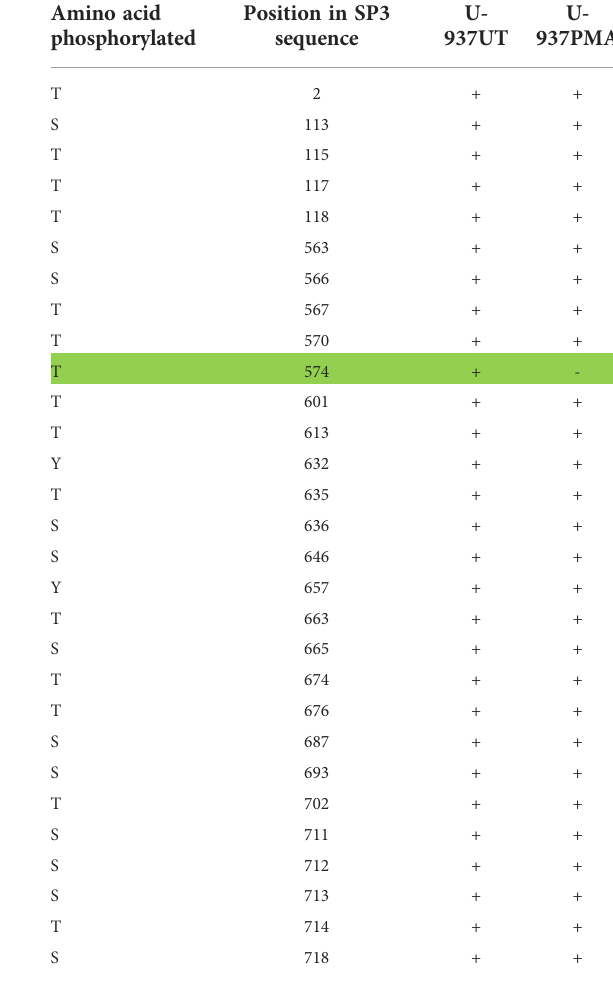
(UT- untreated and PMA- PMA 0.5 m M treated). (+indicatesphosphorylation;-indicatednophosphorylation;phosphoRsiteprobabilities of 75% or more were considered; green boxes highlight a dephosphorylation